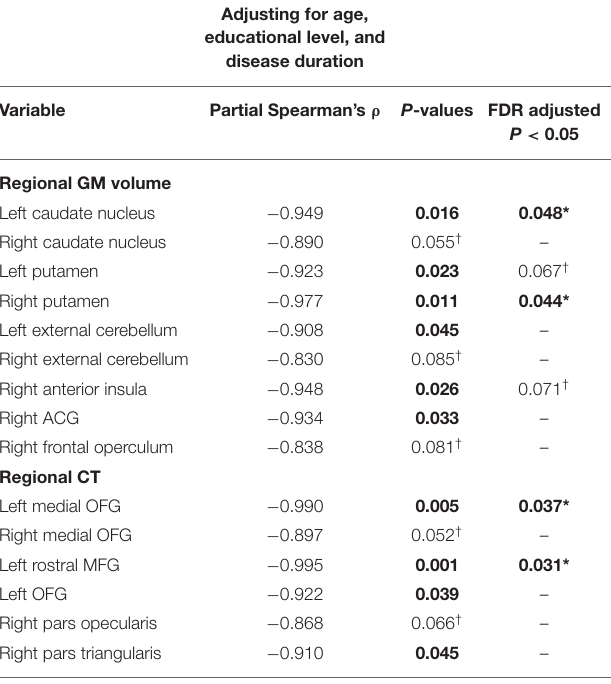
TABLE 2 | Spearman partial correlations analysis controlling for age, educational level, and disease duration between log beta power in the STN and both regional gray matter (GM) volume and cortical thickness